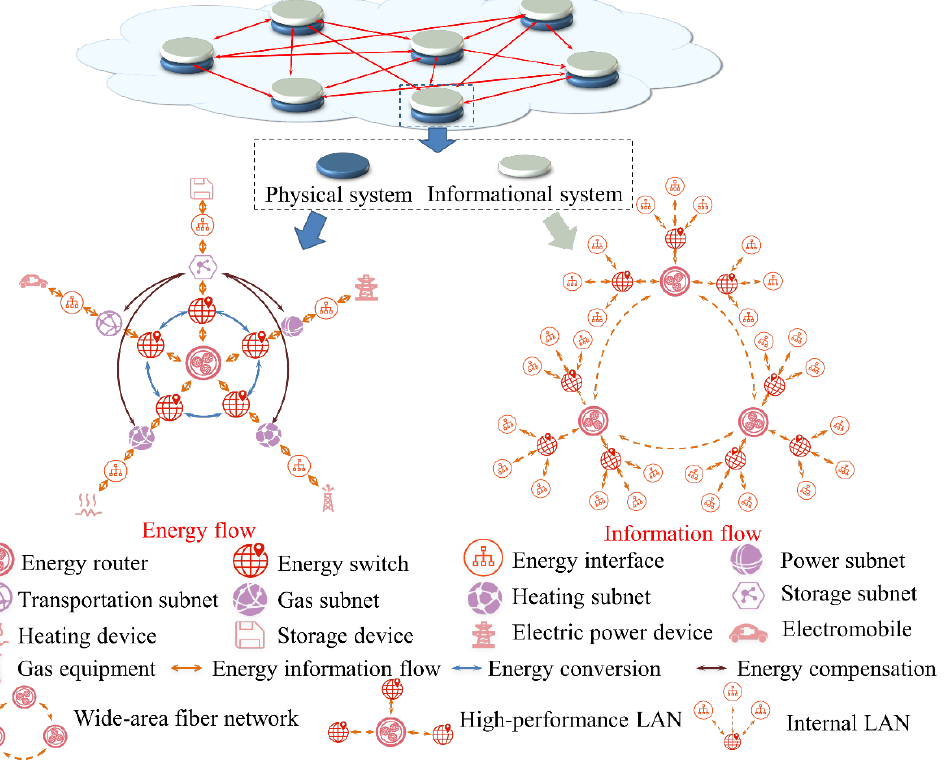
Figure 1. The partitioning-hierarchical architecture of the energy internet.